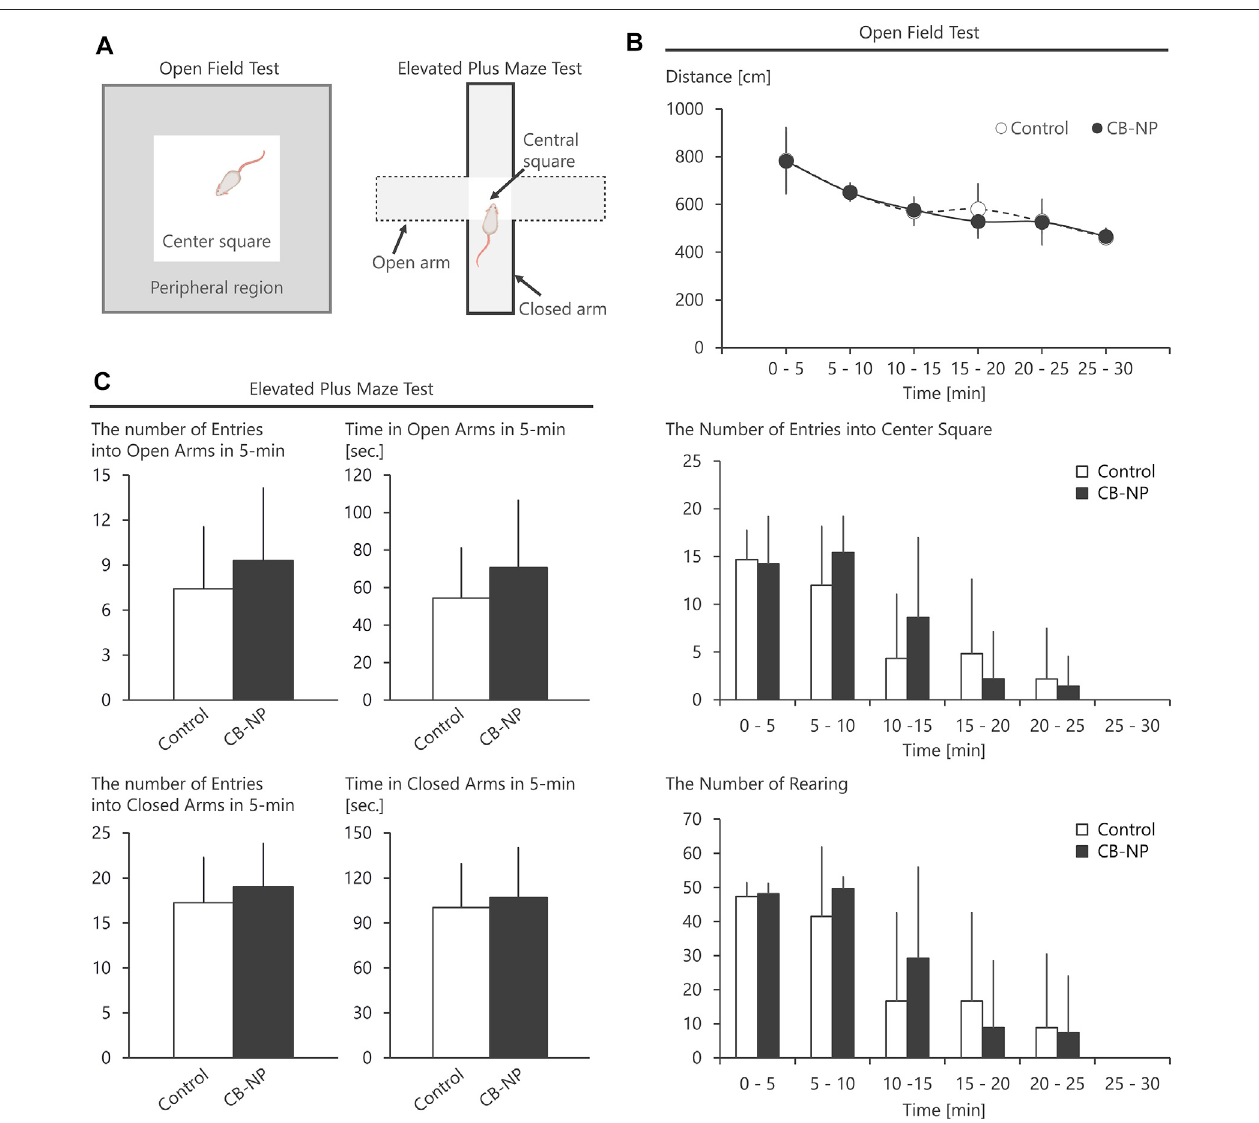
FIGURE 7 | Behavioral tests using open fi eld and elevated plus maze. The effect of maternal carbon black nanoparticle exposure on behavior associated with spontaneous locomotor activity and anxiety-like behavior was evaluated. (A) Schematic diagrams of the open fi eld test and the elevated plus maze test. (B) Total distance, the number of visits to the center square of the open fi eld, and the number of rearing in the open fi eld. (C) The number of visits to open arms or closed arms in the elevated plus maze during 5-min and spending time [s] in the open arms or closed arms for 5-min. Values are expressed as the mean ± standard deviation. n = 8. The white column indicates the control group and the black column indicates the carbon black nanoparticle exposure group.